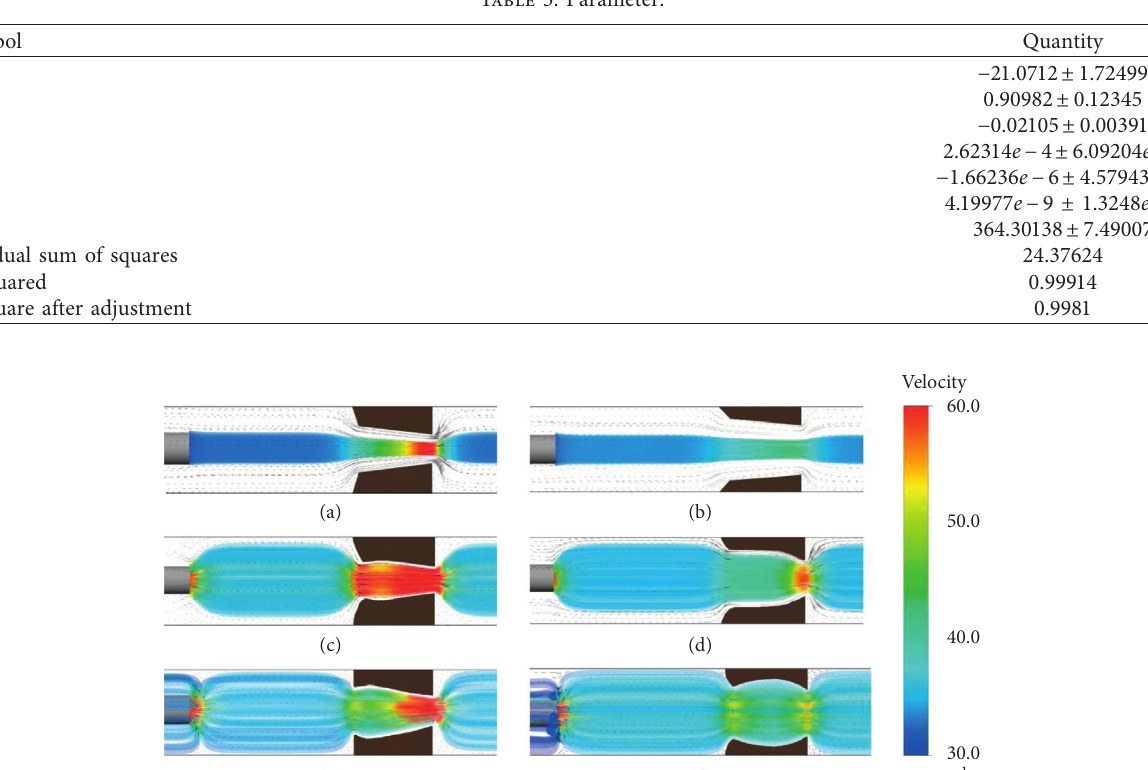
Figure 7: Voidage of lytic process for clot length of (a) 0.1 mm, (b) 0.2mm, and (c) 0.3mm. The range of voidage is from 0.980 to 1.000. The red regions denote areas of complete dissolution, while blue regions mean that the dissolution has not started yet. Table 3: